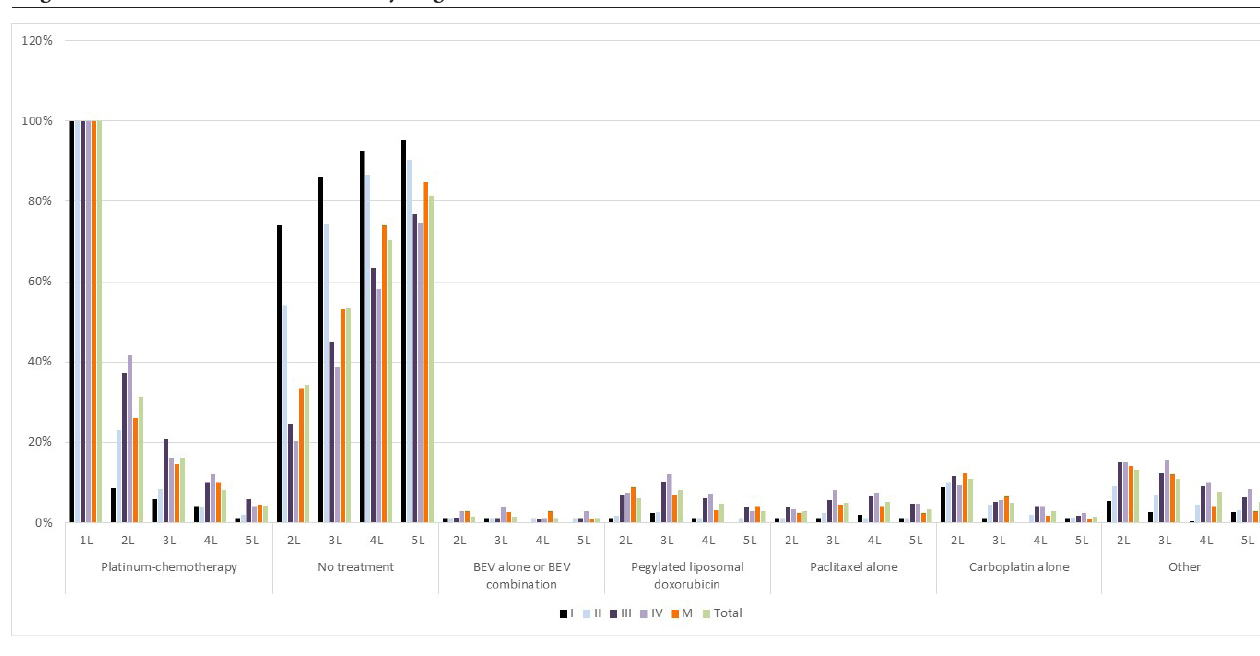
Figure 1. Treatment Patterns Stratified by Stage of Disease